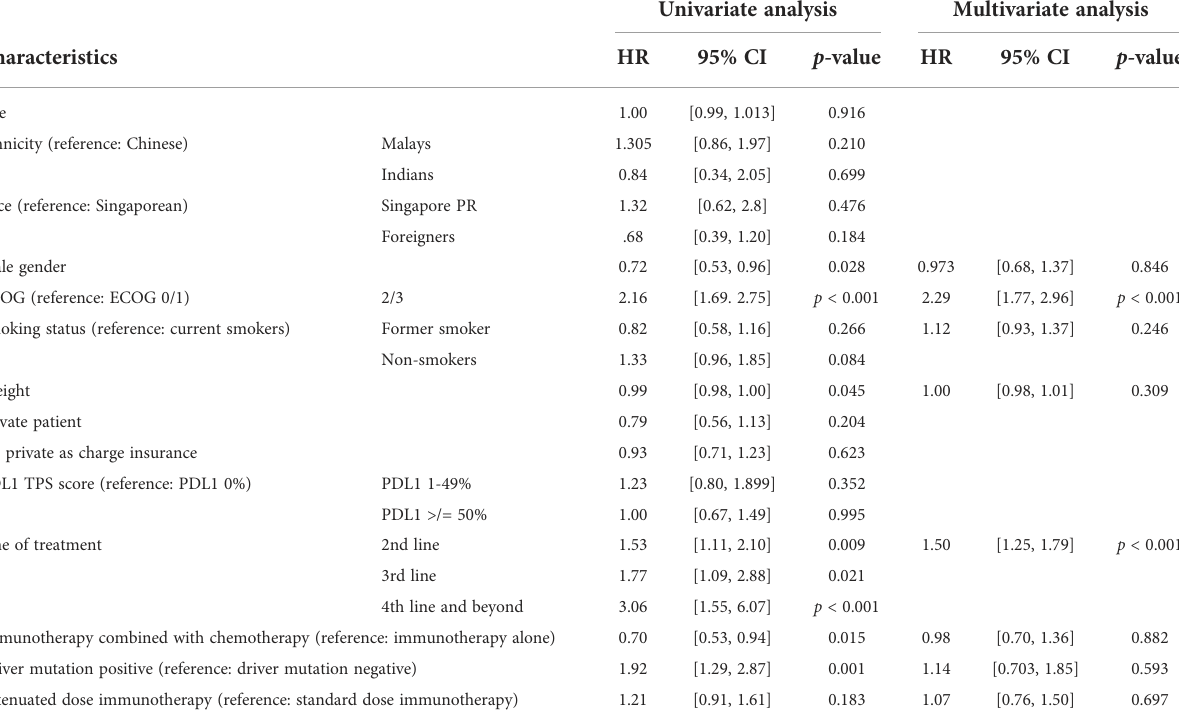
TABLE 3 Univariate and multivariate Cox regression for progression free survival.